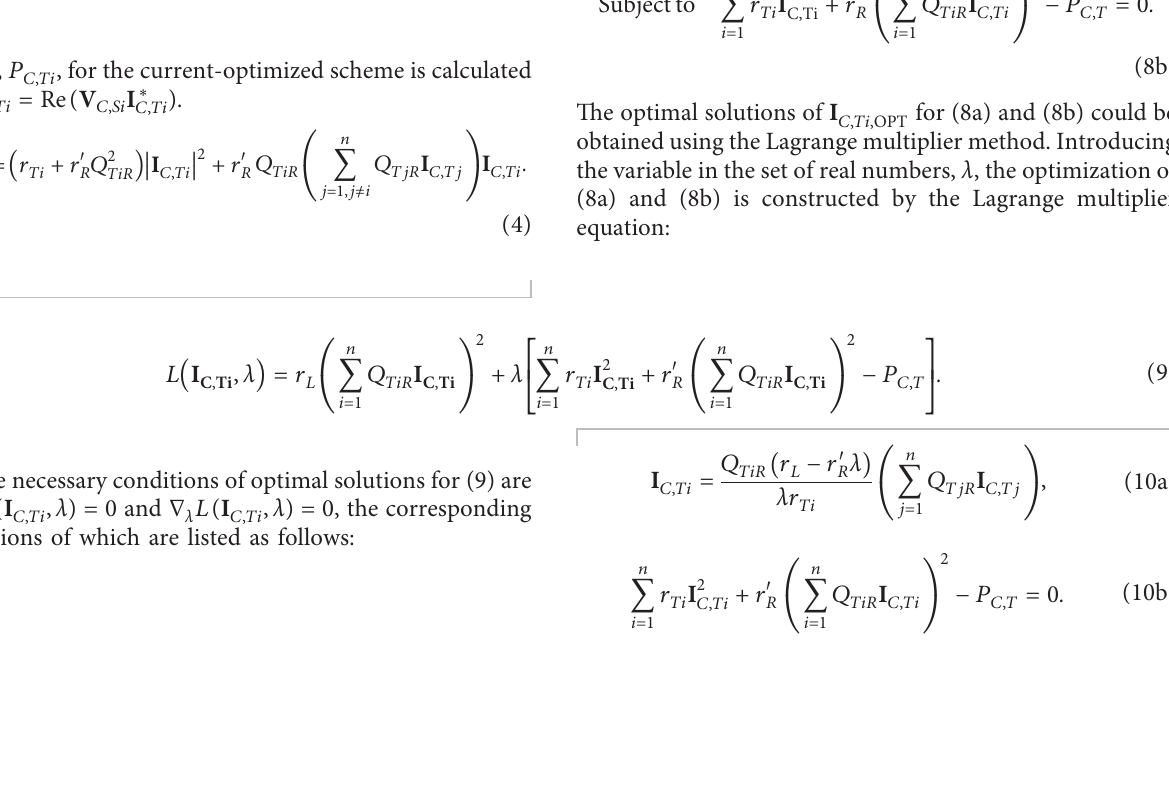
Figure 1: Circuit topology of the current-optimized circuit scheme of multiple-TX WPT